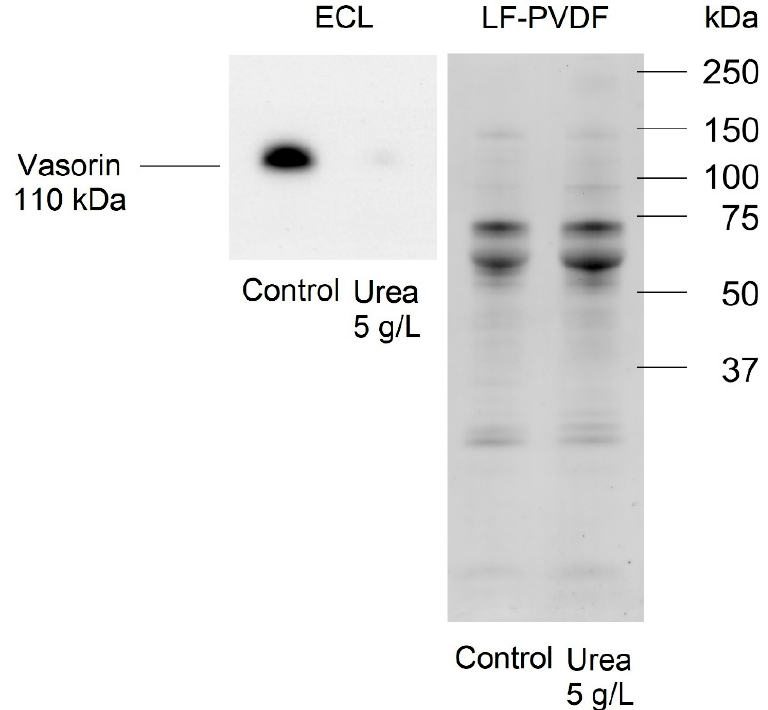
Figure 12. Effect of urea on the expression of the secreted form of vasorin. ECL and LF-PVDF membrane stained with a total protein stain to check the transfer efficiency showing vasorin level assessed by Western blot in the secretome of control HMEC-1 and HMEC-1 treated with 5 g/L urea for 72 h.